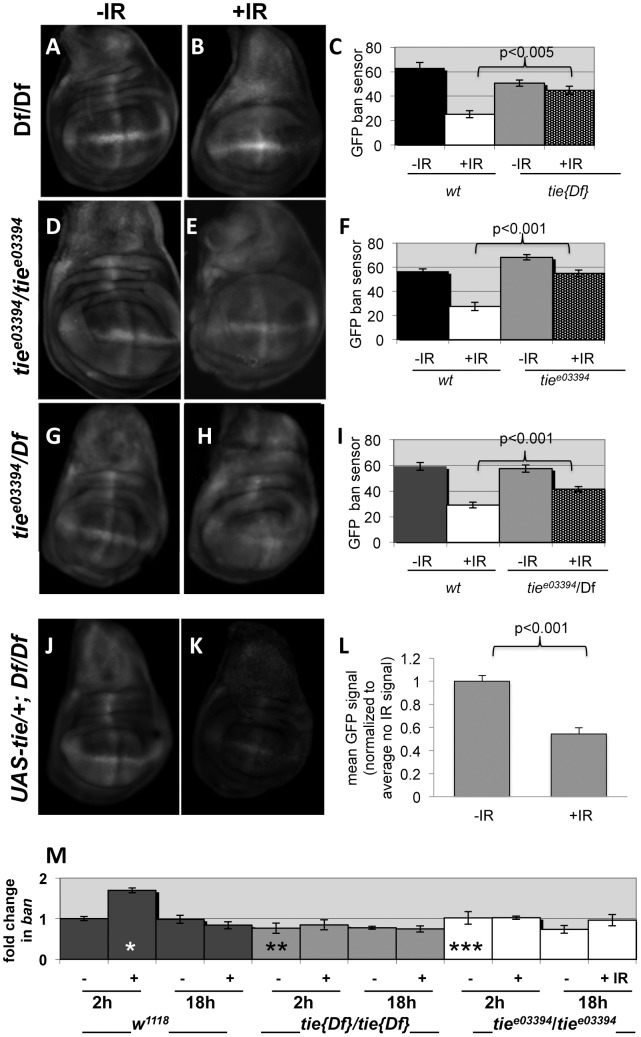

tie is needed for IR-induced changes in GFP ban sensor.(A–I) Third instar larvae were irradiated at 96±2 hr after egg deposition with 0R (-IR) or 4000R (+IR) of X-rays and wing discs imaged live 24 h later. Images were acquired and treated identically. The mean GFP signal was quantified for each disc using Image J, and the averages are shown for each genotype/treatment. Age-matched sensor only controls (i.e. wild type for tie) were included in each experiment (images not shown here but see Fig. S1). (A–C) Wing discs from homozygotes for Df(3L)Exel2098 that removes only tie (‘tie
[17]’). N = 31, 28, 31 and 31 discs (left to right) in three independent experiments. (D–F) Wing imaginal discs from homozygotes for tiee03394. N = 26, 27, 26 and 25 discs (left to right) in three independent experiments. (G–I) Wing imaginal discs from trans-heterozygotes tiee03394/Df(3L)Exel2098. N = 29, 29, 30 and 30 discs (left to right) in three independent experiments. (J–L) Wing imaginal discs from Df(3L)Exel2098 homozygotes that carry one copy of a UAS-tie transgene. The data are from 5 discs per sample in two independent experiments. The larvae carried two copies of the GFP sensor in A-I and one copy in J-L. Error bar =  ±1SEM. p-values reflect a comparison of two samples at the ends of each bracket. (M) tie is needed for IR-induced changes in ban levels. Quantitative RT-PCR was used to quantify mature ban miRNA. The values were normalized to an internal a-tubulin control, and expressed as fold change from un-irradiated w1118 controls (‘w2-’ set at 1). ‘-‘  =  no IR; ‘+’  =  4000R. ‘w’  =  w1118; Df’  =  homozygotes of Df(3L)Exel2098 that removes only tie; ‘3394’  =  tiee03394 homozygotes. *  =  difference compared to w2-. ** and *** =  significance compared to w2+. *  =  p <0.01; **  =  p <0.001; ***  =  p < 10−6. Student's t-test was used to determine significance.